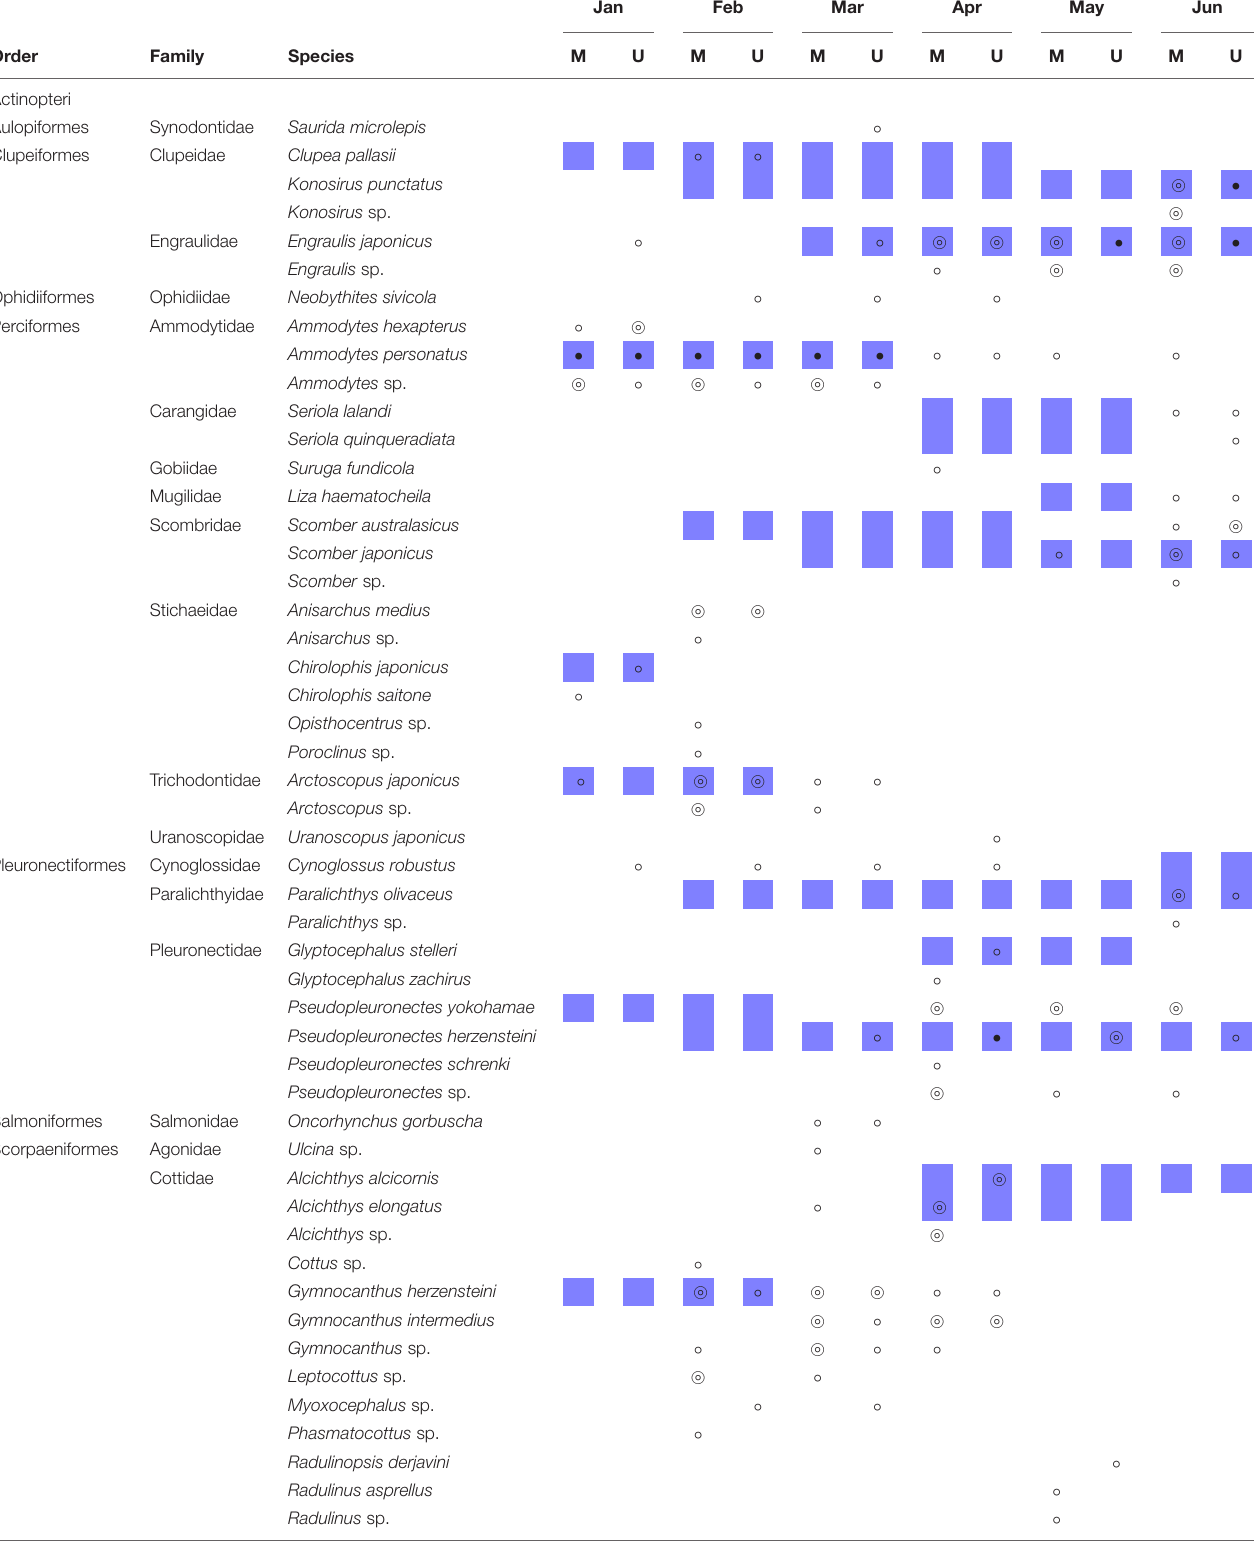
TABLE 5 | Detection of ichthyoplankton in each month by metabarcoding analysis with two universal primers, MiFish (M) and FishU